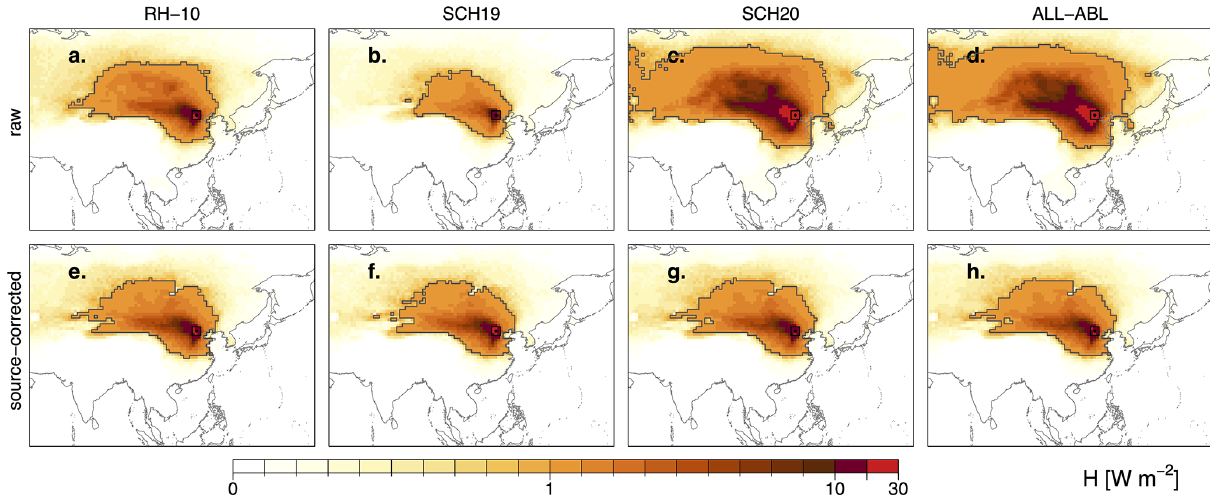
Figure 5. Source regions of heat for moisture-dependent thresholds using the RH-10 criteria (a, e) , SCH19 criteria (b, f) , SCH20 criteria (c, g) , and all potential temperature increases in the ABL (ALL-ABL; d, h ) averaged over the period 1980–2016. Rows show the biased source regions (a–d) and the source-corrected source regions of heat (e–h) . The dark grey lines mark the 1Wm − 2 source regions, i.e., all contributions larger than 1Wm − 2 . Note that the color scale is